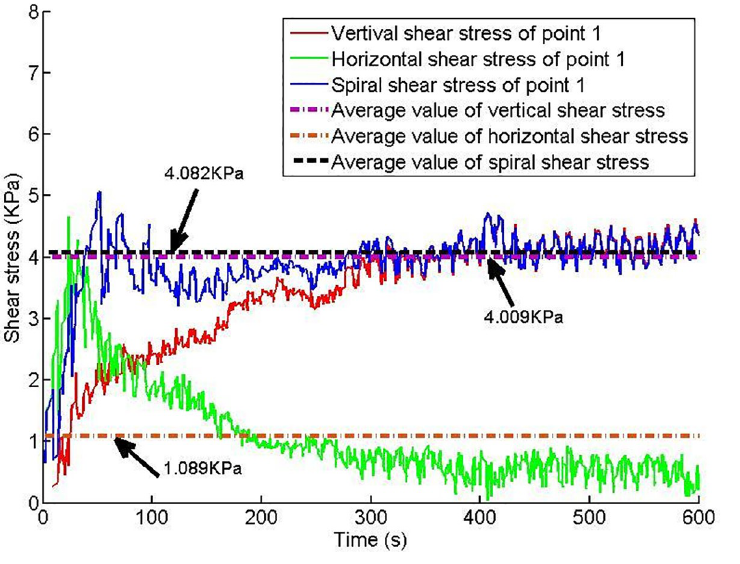
Fig 13. Shear stress of testing point 1.